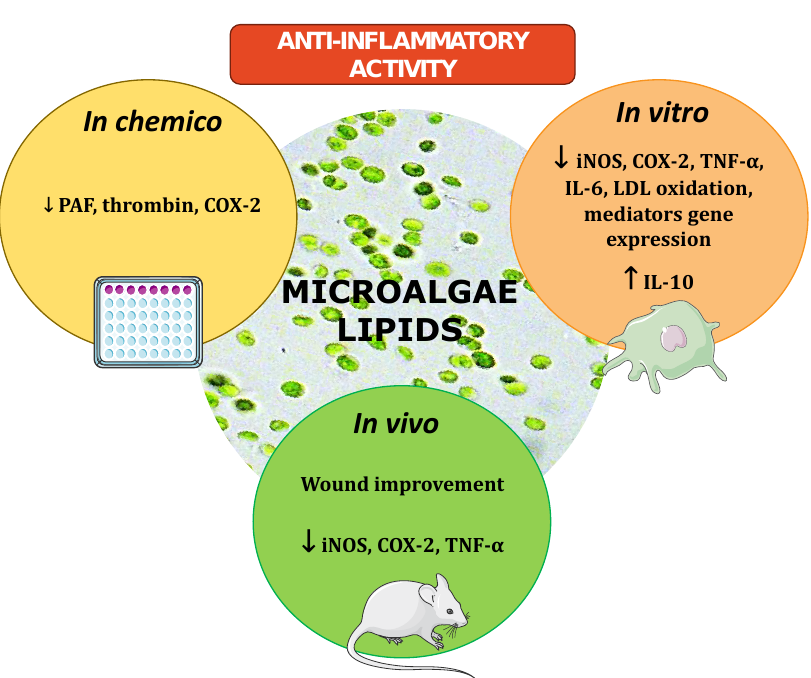
Figure 4. Schematic representation of the anti-inflammatory potential of microalgae lipids. The scheme was based on the data collected and overviewed in Section 3. Microalgae crude lipid extracts, glycolipids, phospholipids, and other isolated lipids (e.g., oxylipins) displayed in vivo and in vitro anti-inflammatory activity with down-regulation of the pro-inflammatory mediators COX-2, iNOS, TNF- α , IL-6, and